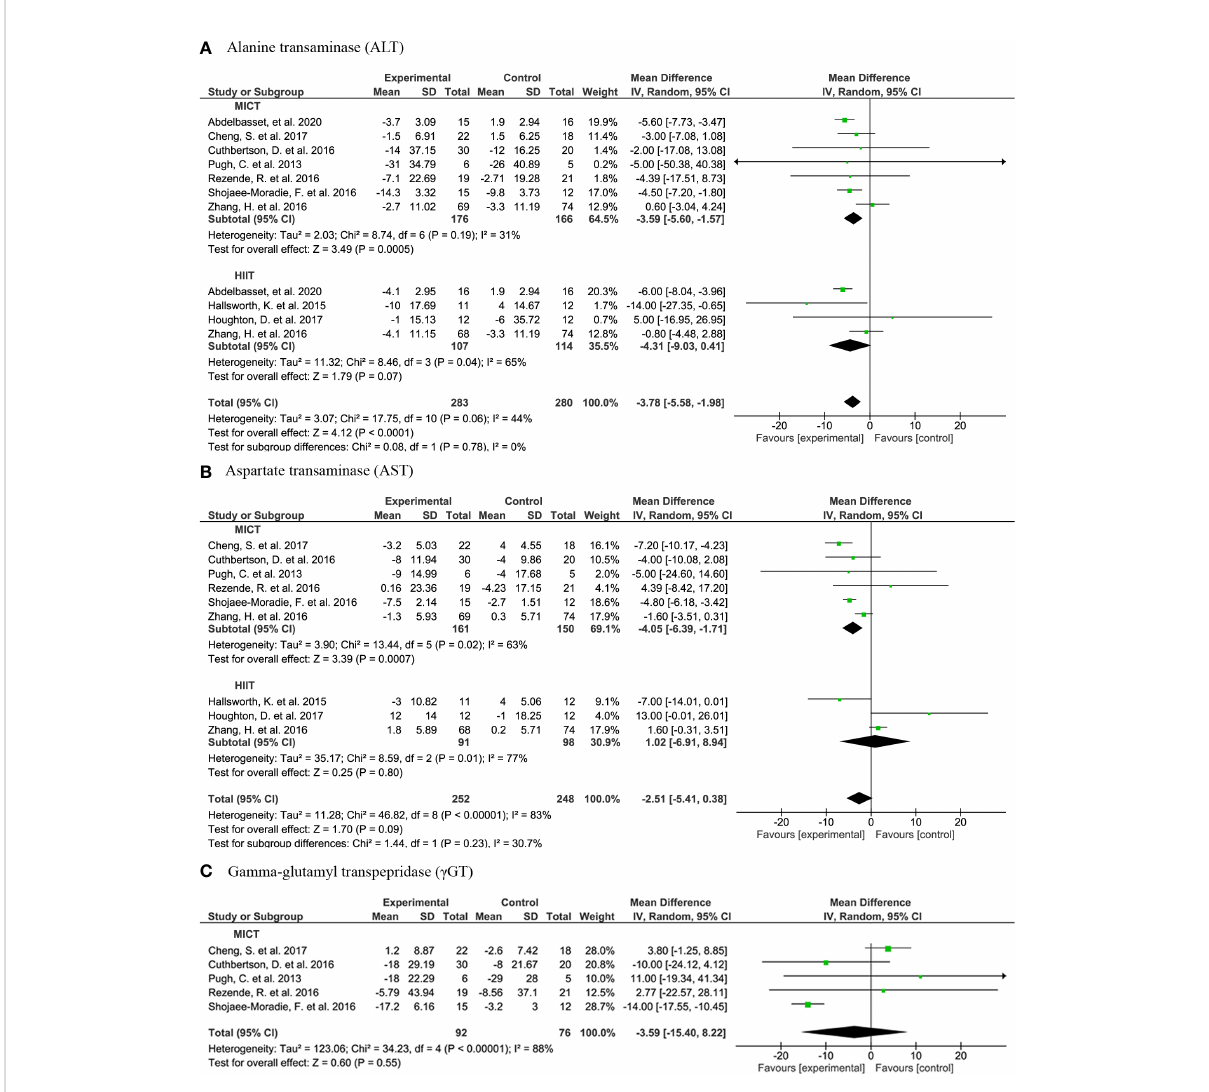
FIGURE 2 Forrest plot for the effect of moderate-intensity continuous training (MICT) and high-intensity interval training (HIIT) on liver transaminases: (A) alanine transaminase (ALT); (B) aspartate transaminase (AST); (C) Forrest plot for the effect of MICT on gamma-glutamyl transpeptidase ( g